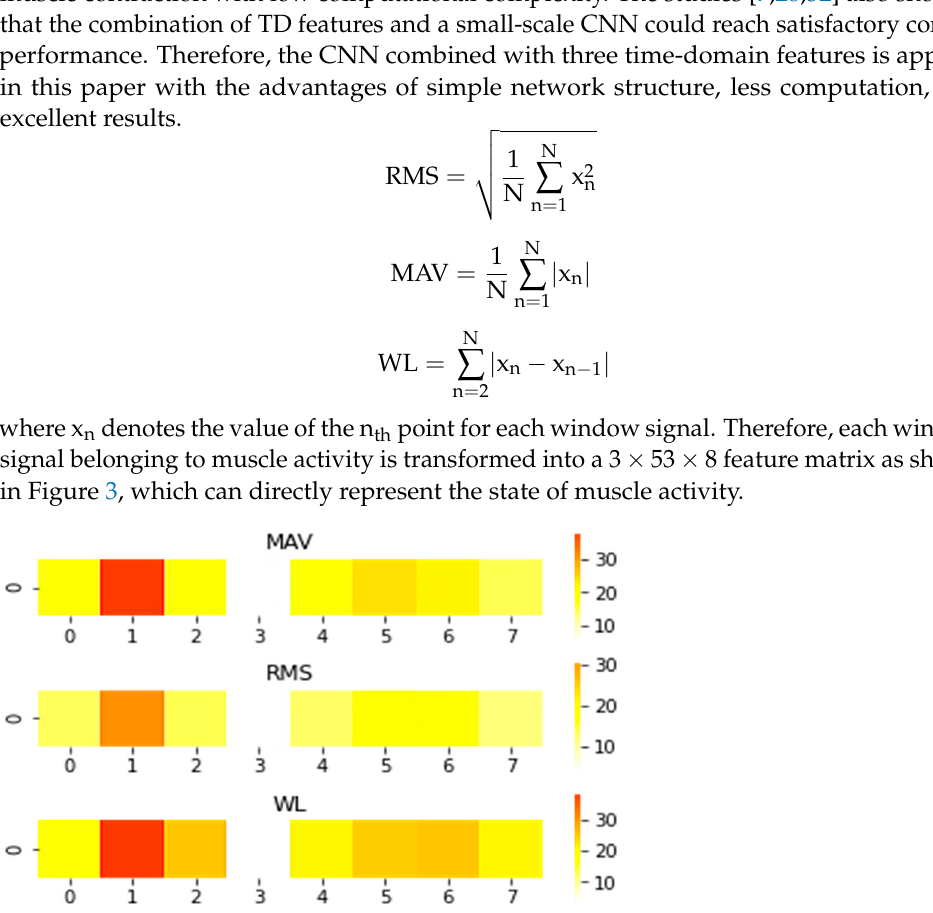
Figure 3. The sEMG images correspond to the target movements of 8 channels’ sEMG signals.